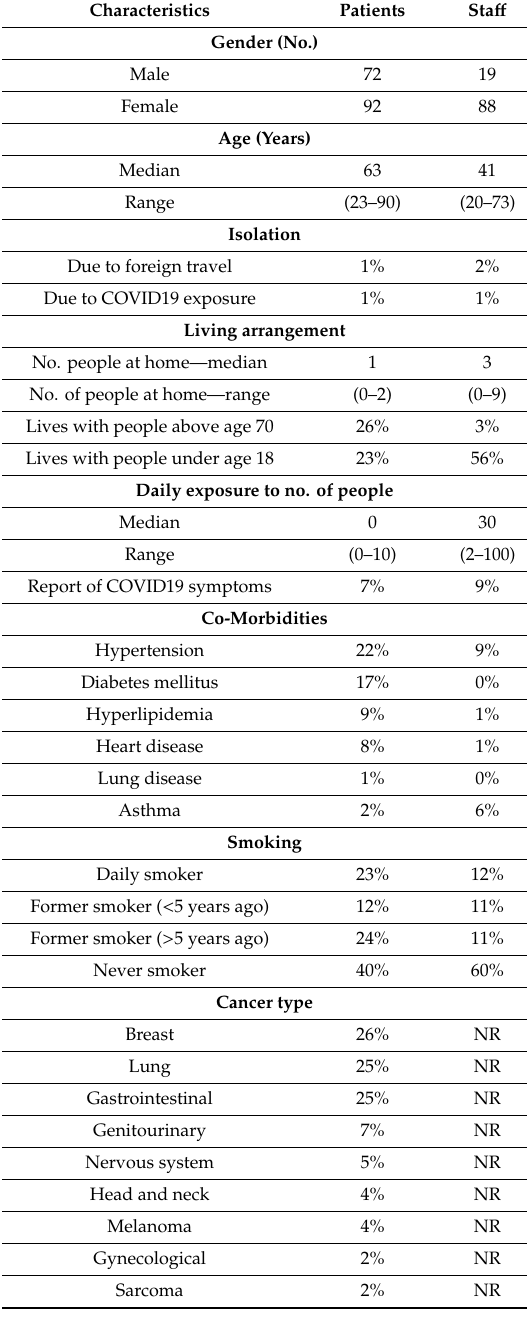
Table 1. Participant-, disease-, and treatment-related